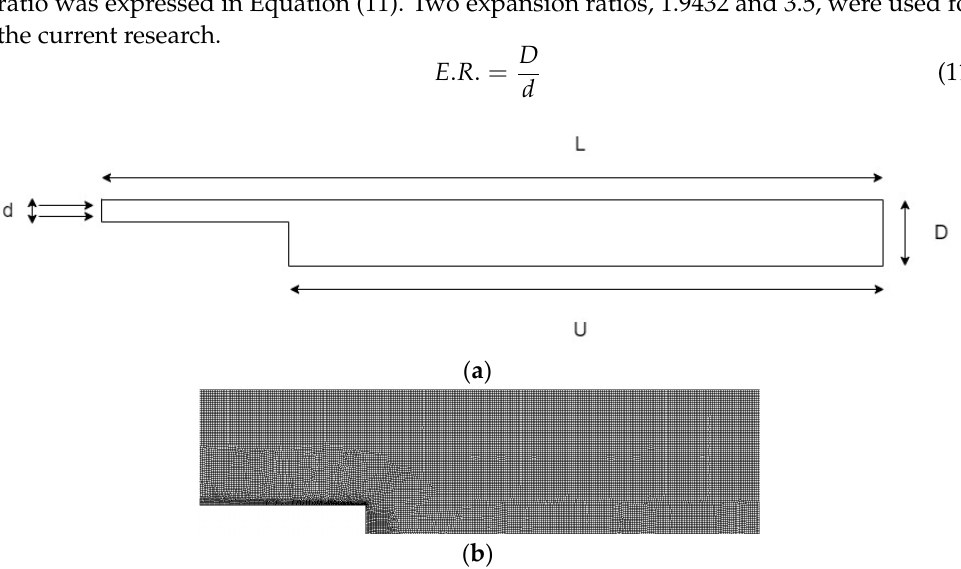
Figure 1. ( a ) Problem geometry; ( b ) computational mesh for ER—1.9432; ( b ) zoomed out computa- tional mesh.